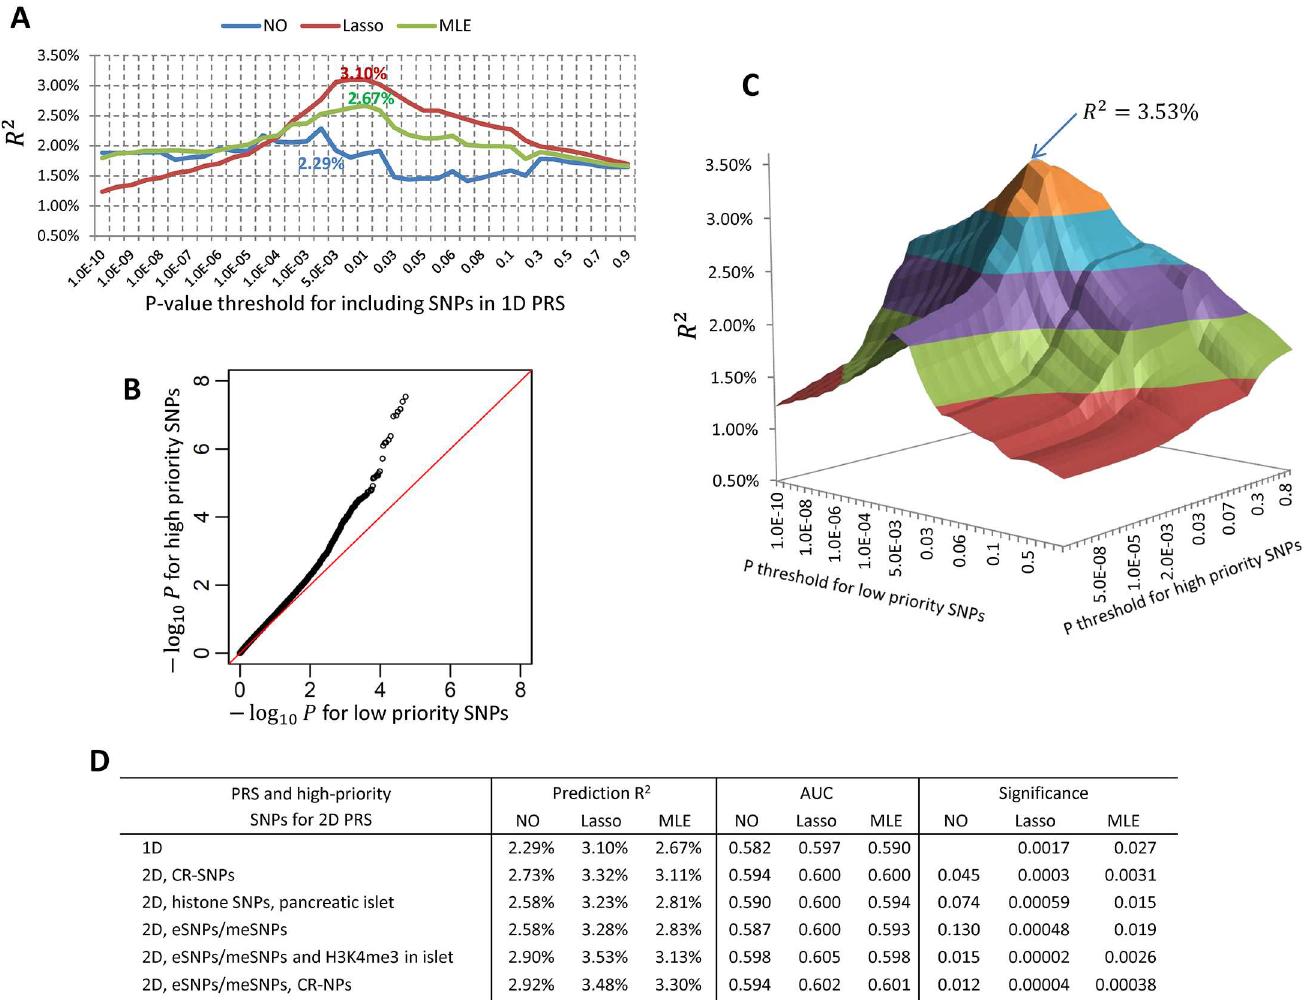
Fig 3. Genetic risk prediction for type-2 diabetes. PRS models were built based on the summary statistics from a meta-analysis of DIAGRAM consortiumand GERA data (17,802 cases and 105,109controls in total) and validatedin independent 1500 cases and 1500 controls in GERA. (A) PredictionR 2 (observational scale) for 1D PRS with or without winner’scurse correction. “NO”: no winner’scorrection for associationcoefficients; “Lasso”: regressioncoefficients were modifiedby a lasso-typecorrection; “MLE”: association coefficients were modified by maximizinga likelihood function conditioning on selection.(B) Quantile-quantile plot for − log 10 ( P ) for high priority (HP) SNPs vs. low priority (LP) SNPs. SNPs were prunedto have pairwise r 2 (cid:20) 0.1. Here, the HP SNPs were eSNPs/meSNPs in adiposetissue or SNPs related with the H3K4me3mark in pancreaticislet cell line with data downloaded from the ROADMAP project. The HP SNPs were strongly enrichedin the discovery data. (C) Prediction R 2 for 2D PRS with lasso- type winner’scurse correction. The SNP set was the same to (B). The best prediction(R 2 = 3.53%) was achievedwhen we includedHP SNPs using criterion P (cid:20) 0.03 and LP SNPs with P (cid:20) 0.005. (D) The predictionR 2 , the area under the curve (AUC) and the significances for testing whetheran alternative PRS was better than the standard